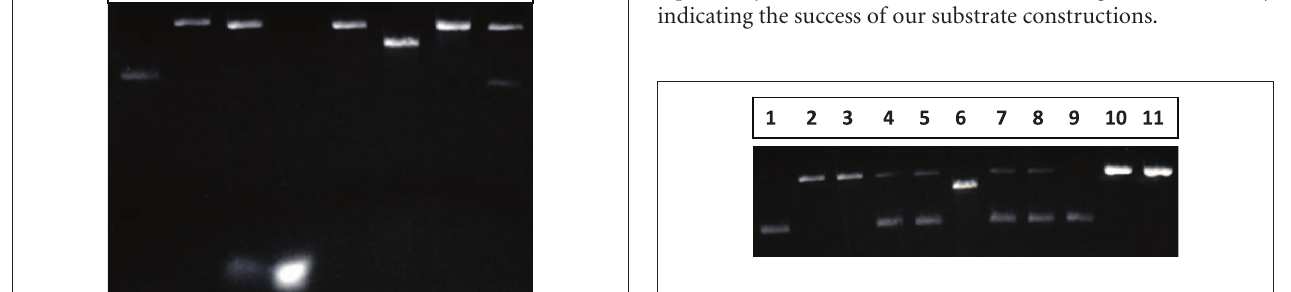
Figure 4 | generation and identification of the mismatch DNA substrate. Lane 1: pWDAH1A plasmid (supercoiled DNA); Lane 2, 3: gap